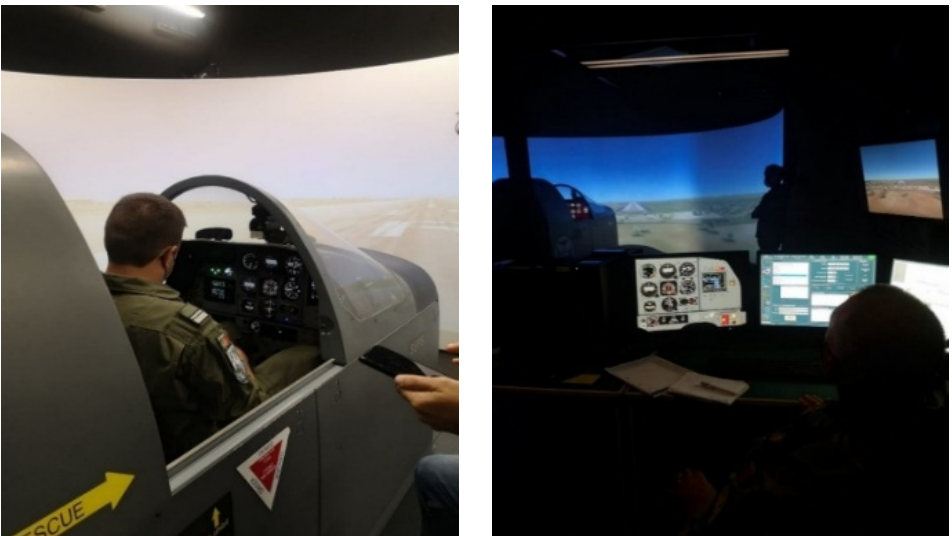
Figure 1. Left , the inside of the cockpit for the flight simulator Epsilon TB-30 and a pilot ready to start the protocol. Right , the inside of the control room and the setup device of the flight simulator operator.